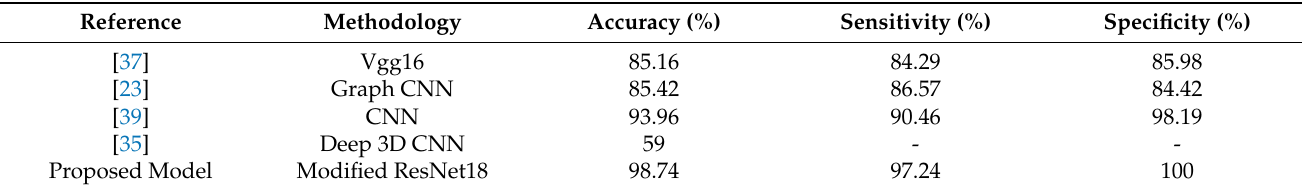
Table 9. Evaluation Results with the CN vs. EMCI Binary Classification.